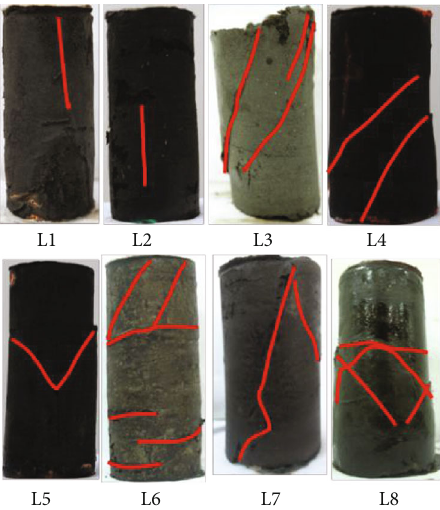
Figure 13: Failure patterns of oil sand under di ff erent con fi ning pressures and